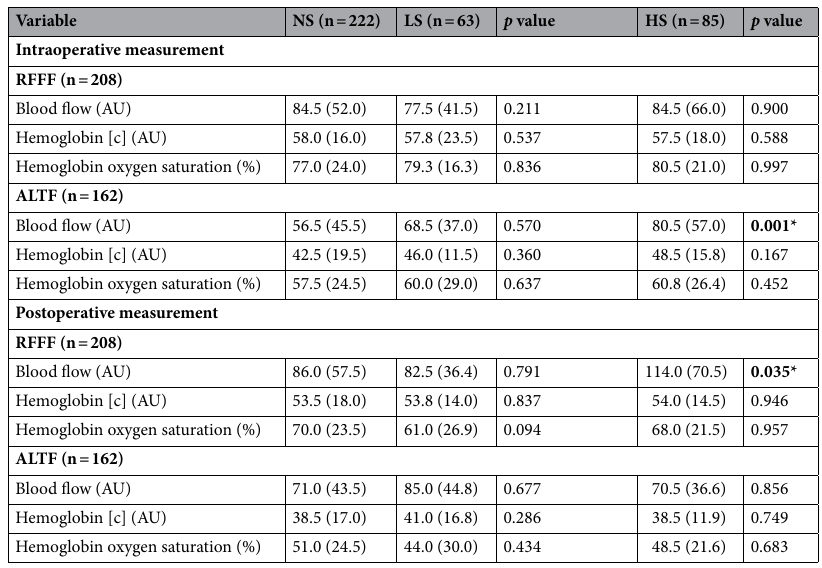
Table 3. Flap perfusion parameters. Parameters are indicated as median (with interquartile range) for intraoperative and postoperative measurement of RFFF and ALTF (separately described for the group of nonsmokers (NS), the group of light smokers (LS) and the group of heavy smokers (HS)); p values corresponding to testing for differences between groups (NS vs. LS and NS vs. HS) with Mann Whitney test; significant p values are bold (* p values < 0.05 with adjustment for sex, age, BMI, diabetes, mean arterial pressure and catecholamine dose); NS nonsmokers, LH light smokers, HS heavy smokers, RFFF radial free forearm flap, ALTF anterolateral thigh flap, AU arbitrary units, [ c ] concentration.